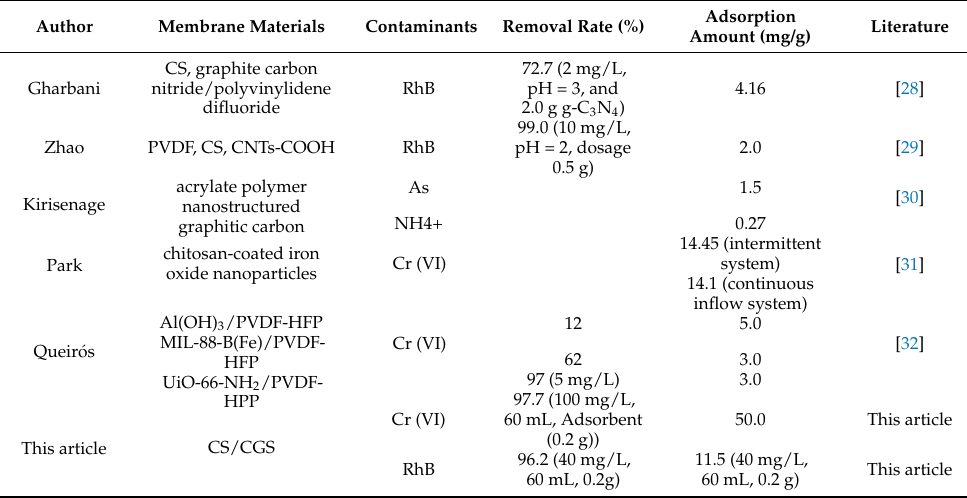
Table 2. Comparison of adsorption of pollutants by different composite films.